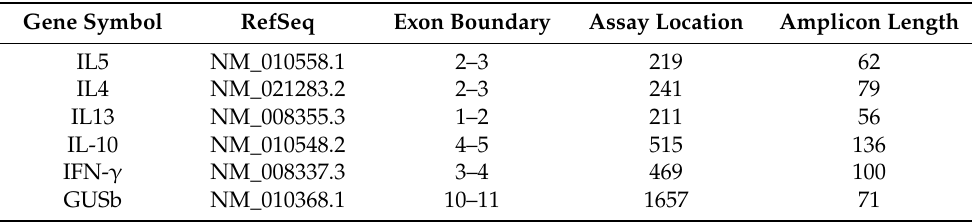
Table 1. Probe TaqMan * details used for real-time PCR